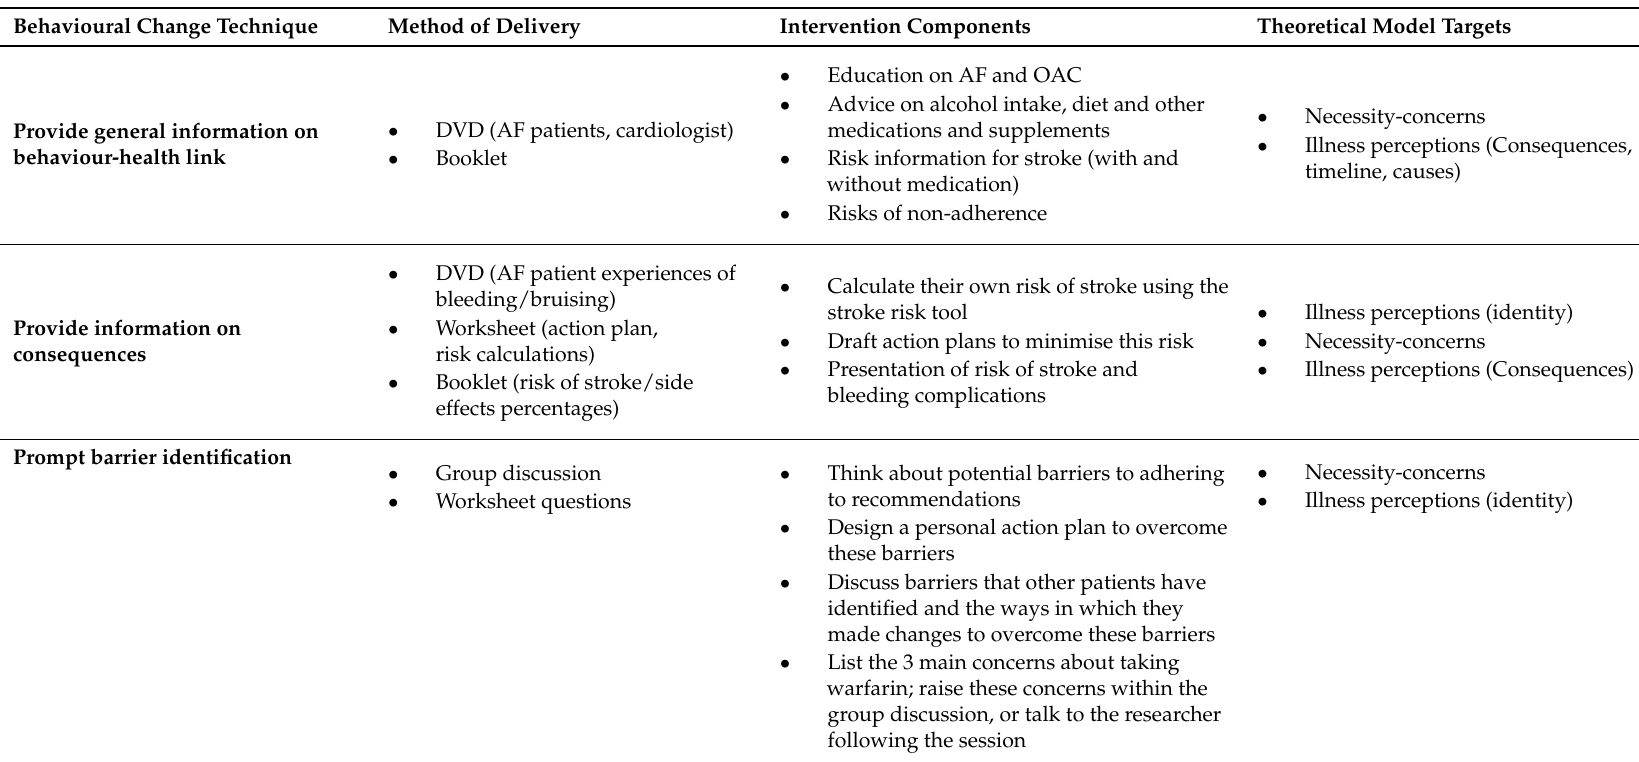
Table 3. Theoretical intervention